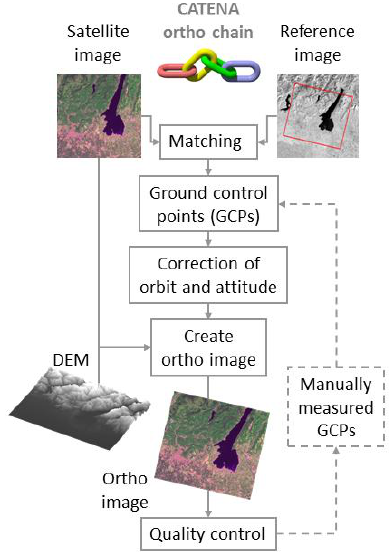
Figure 6: CATENA ortho chain 3 THE CATENA ORTHO